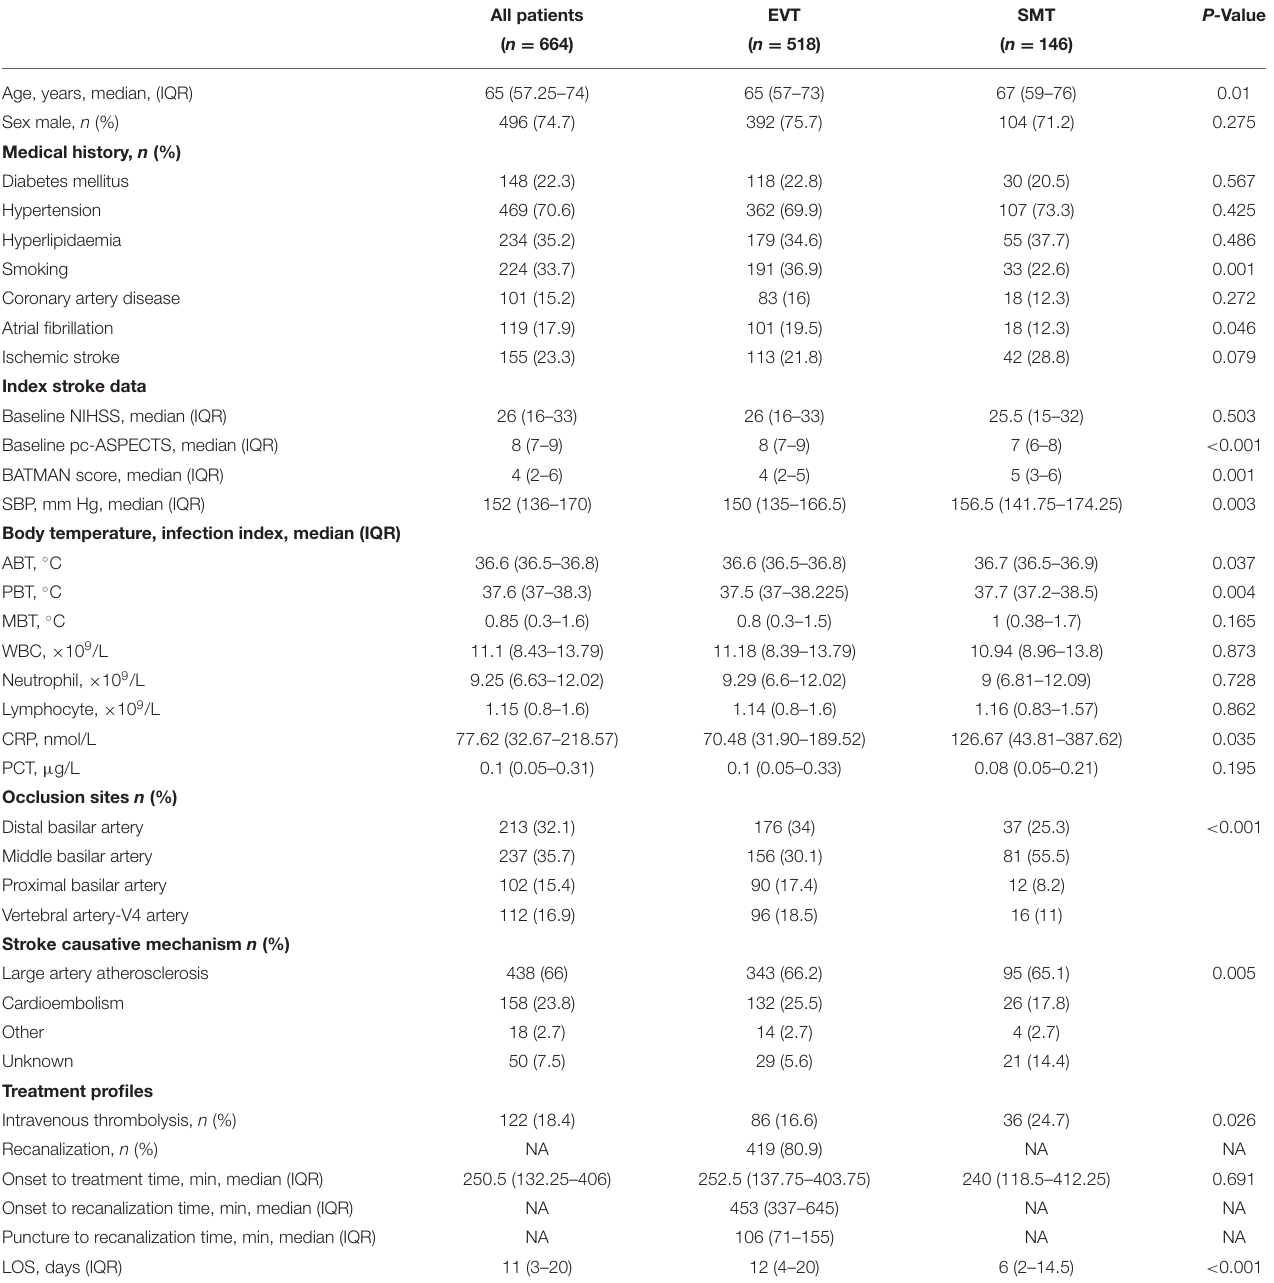
TABLE 1 | Baseline, procedural, and outcome parameters.